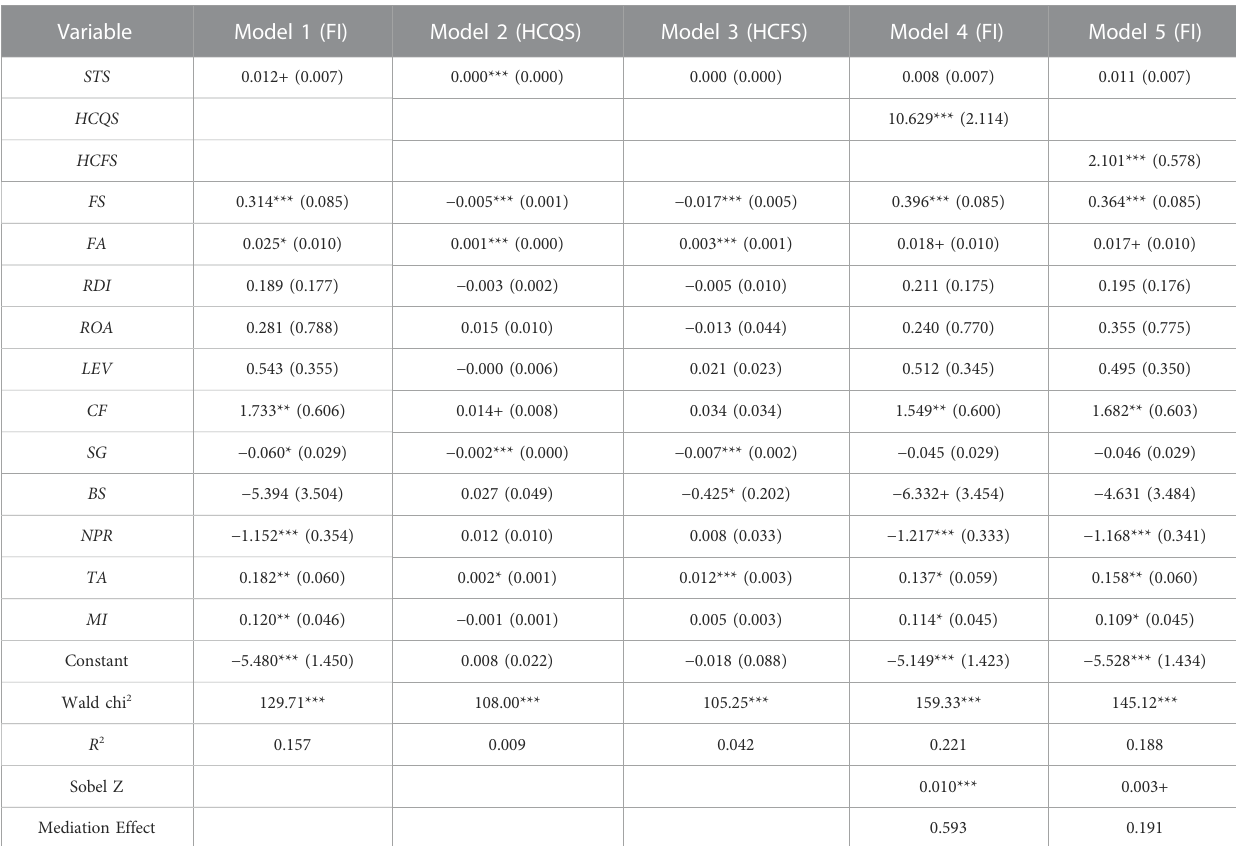
TABLE 13 Endogeneity test of based on the adding control